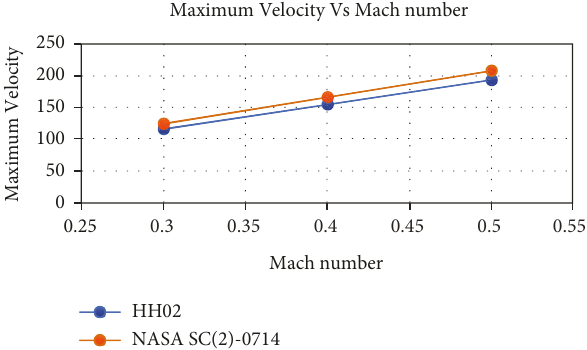
Figure 11: Maximum velocity vs. Mach